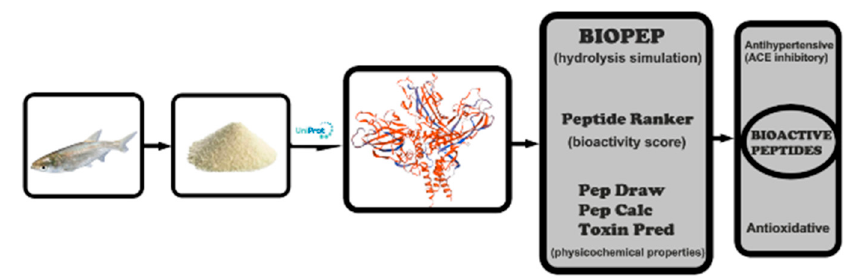
Figure 1. representation of the identification of bioactive peptides from silver